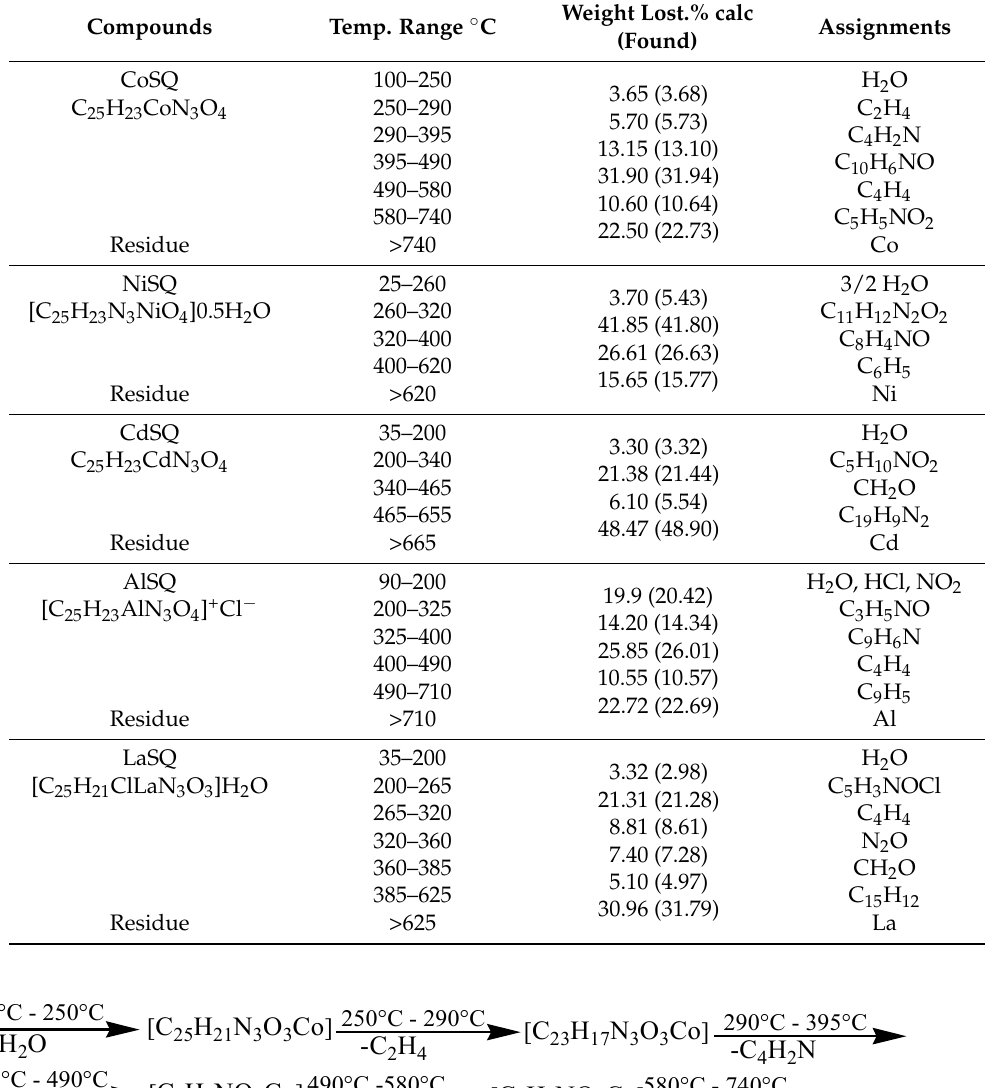
Table 5. Thermogravimetric analysis results for mixed salen/8-hydroxyquinoline metal complexes from ambient temperature to 800 ◦ C and heating rate of 10 ◦ C/min. Weight Lost.% calc Assignments Compounds Temp. Range ◦ C (Found)